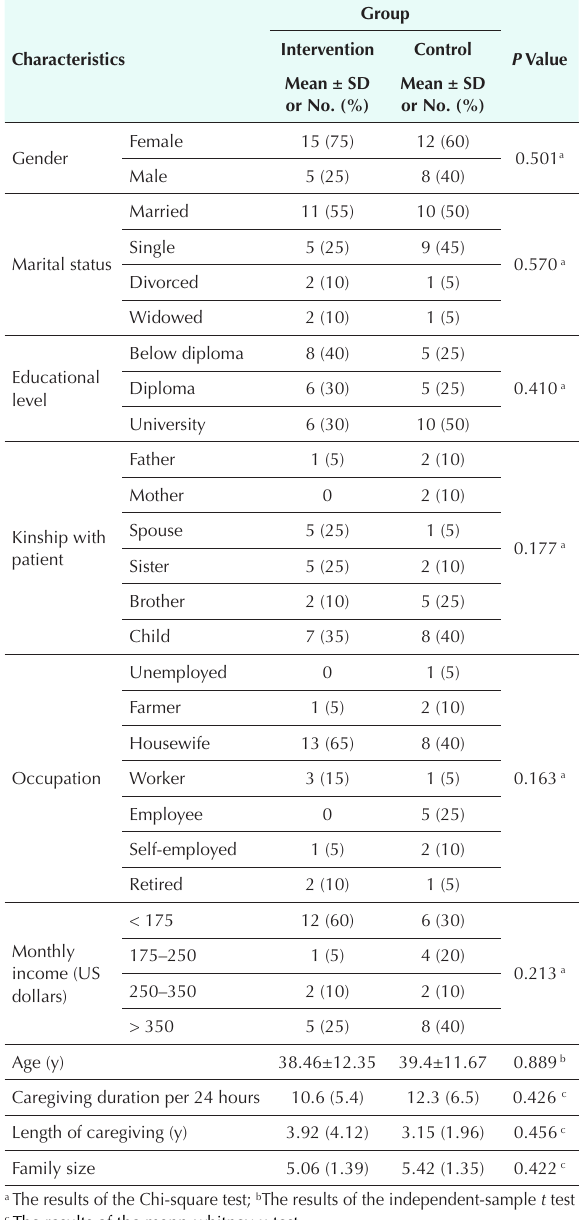
Table 2. Group comparisons with respect to participants’ characteristics